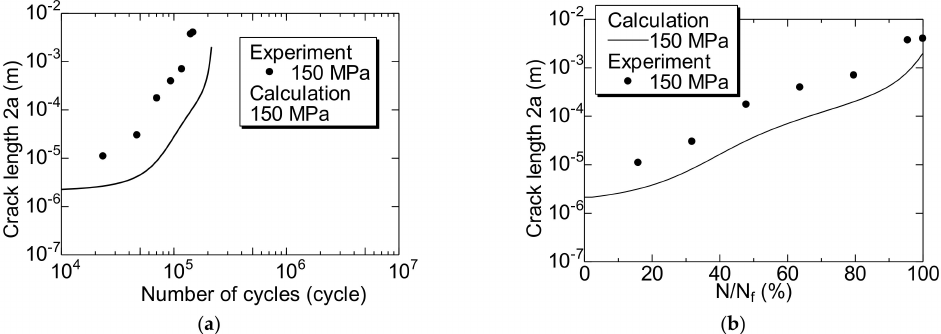
Figure 14. Comparison of the calculation result of the fatigue crack growth curve of the specimen V and the experimental result. ( a ) 2a–N; ( b ) 2a–N/N f . The solid lines in these figures are the calculated results using Equation